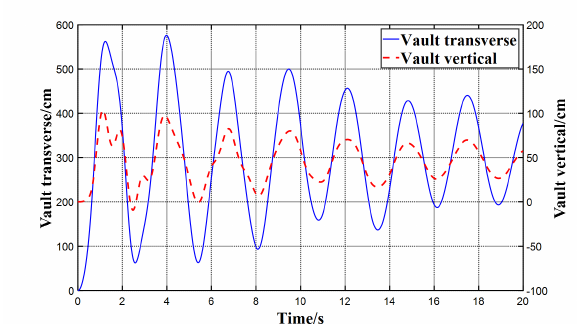
Fig. 11. Vault displacement under longitudinal seismic input